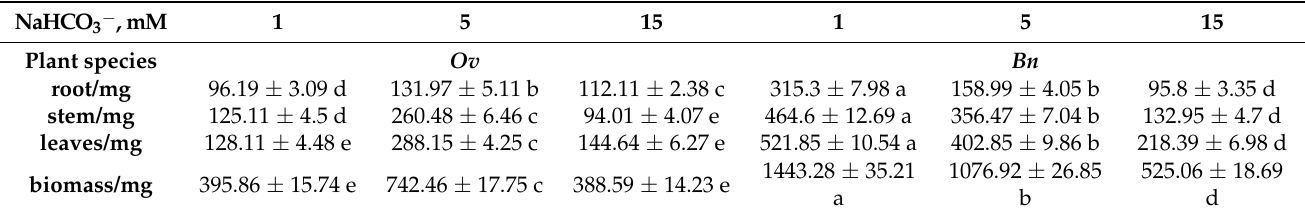
Table 2. The growth of Ov and Bn at various bicarbonate